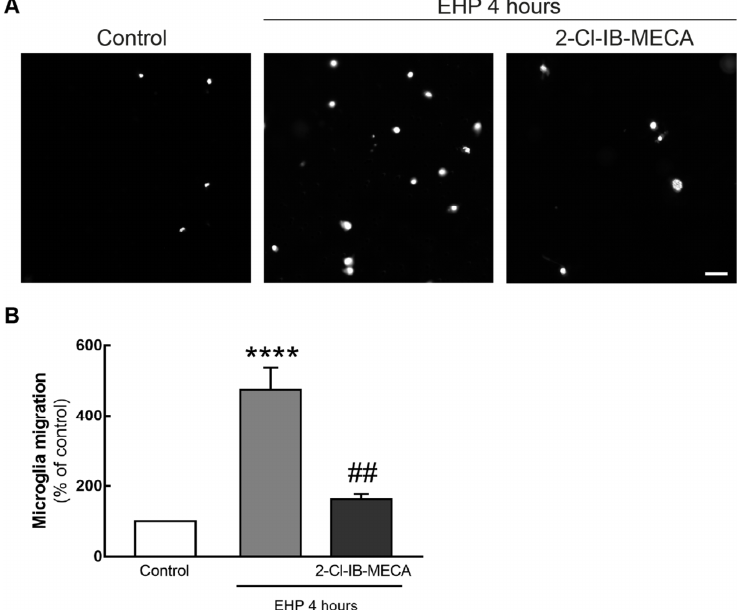
Figure 4. E ff ect of A 3 R activation on EHP-induced BV-2 cell migration. BV-2 cell migration was assessed by Boyden chamber migration assay. Cells were pre-treated with 1 µ M 2-Cl-IB-MECA followed by exposure to EHP for 4 h. ( A ) Representative images are depicted. Scale bar: 50 µm. ( B ) The number of cells in the bottom surface of the transwell was counted and the results are expressed as percentage of control from 5 independent experiments. **** p < 0.0001 compared with control, ## p < 0.01 compared with EHP, Kruskal–Wallis test, followed by Dunn’s multiple comparison test. 2.4. The Activation of A 3 R Prevents EHP-Induced Increase in Microglia Phagocytic Efficiency The effect of the selective A 3 R agonist on the phagocytic efficiency of microglial cells was assessed using fluorescent latex beads. BV-2 cells and primary retinal microglial cells were exposed to EHP for 24 and 4 h, respectively, in the presence or absence of the A 3 R agonist. In BV-2 cells (Figure 5A), the phagocytic efficiency was 19 ± 4% in control conditions. The exposure to EHP significantly increased the phagocytic efficiency to 46 ± 6% when compared with control ( p < 0.01). The pre-incubation with the A 3 R agonist prevented the increase in phagocytic efficiency induced by EHP when compared with EHP conditions ( p < 0.05) (Figure 5B). In primary retinal microglial cell cultures (Figure 6A), the phagocytic efficiency was 5 ± 0.6% in control conditions. The exposure of retinal microglial cells to EHP significantly increased the phagocytic efficiency to 40 ± 8%, when compared with control ( p < 0.01). The activation of A 3 R reduced the phagocytic efficiency in EHP conditions to 23 ± 9%, although not significantly (Figure 6B).